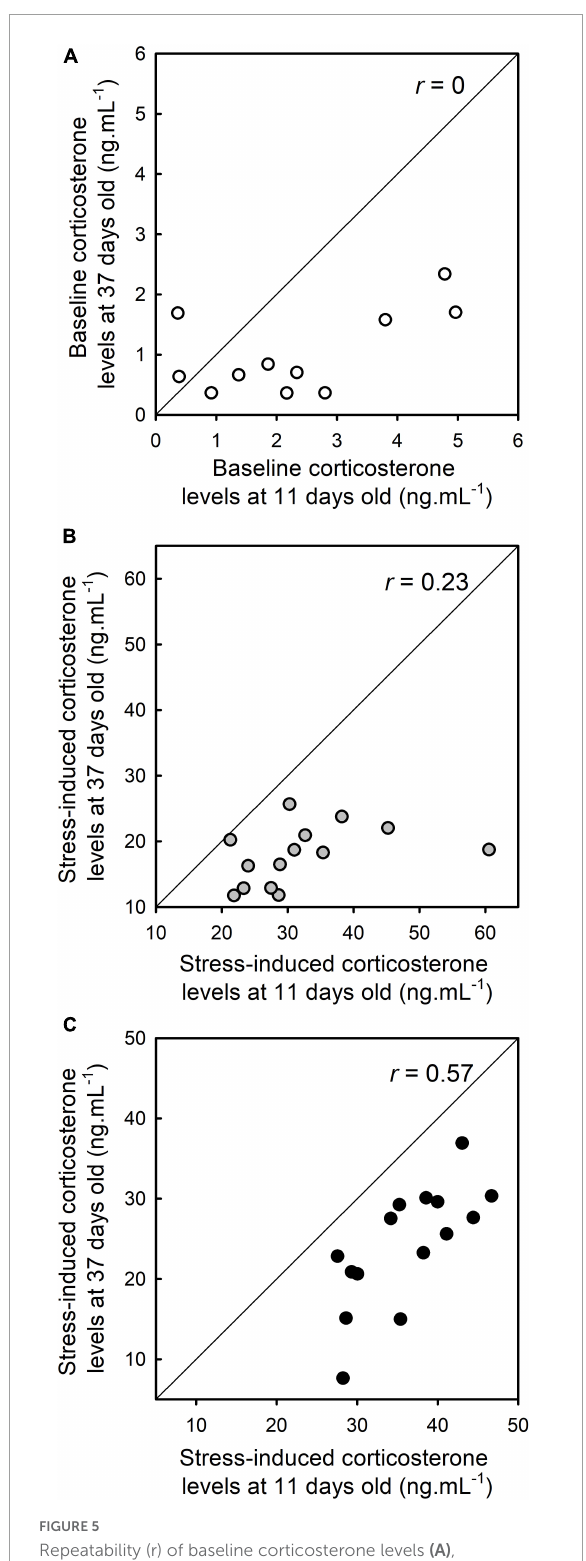
FIGURE5 Repeatability (r) of baseline corticosterone levels (A) , stress-induced corticosterone levels after a 15 min restraint (B) , and stress-induced corticosterone levels after a 30 min restraint (C)